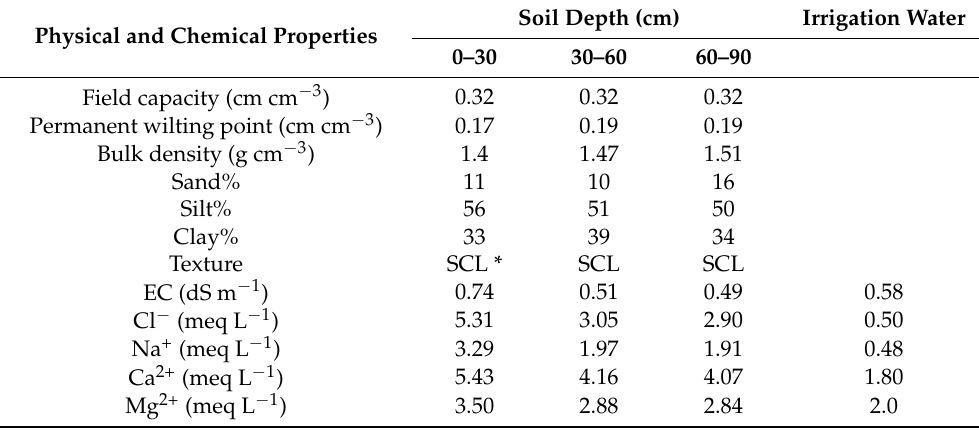
Figure 6. Experimental plot design at planting date ( a ), quinoa at seed filling stage ( b ) and the micro-lysimeter ( c ) for soil water evaporation measurement. Table 4. Soil and water